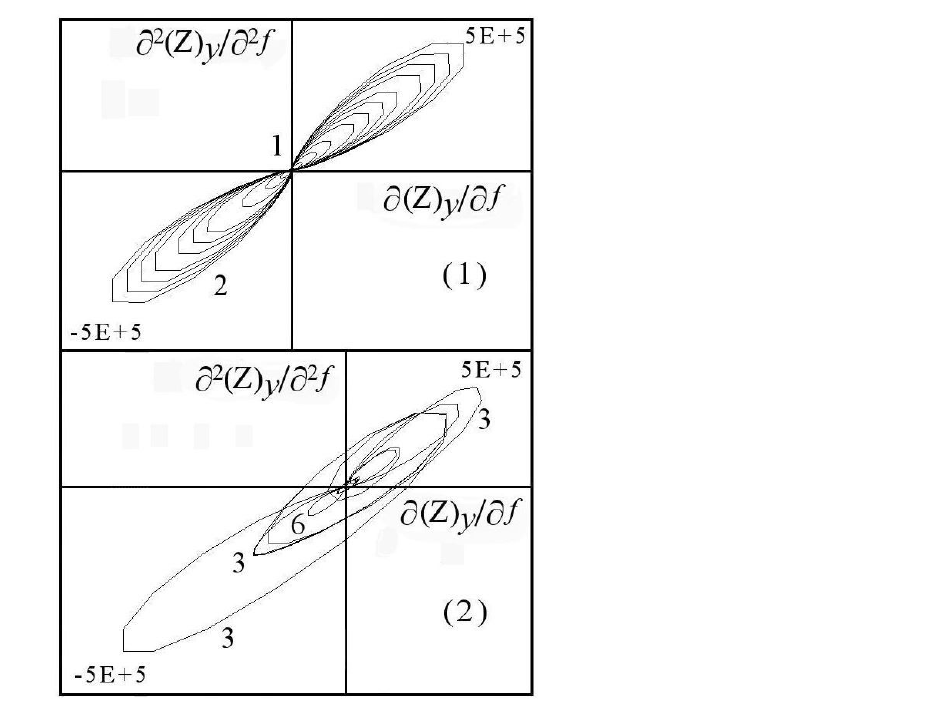
Figure 26. Phase-space at equilibrium potential for two first episodes at high frequency in Figure 24. ( 1 ): oxide adsorption; ( 2 ): oxide rearrangement.